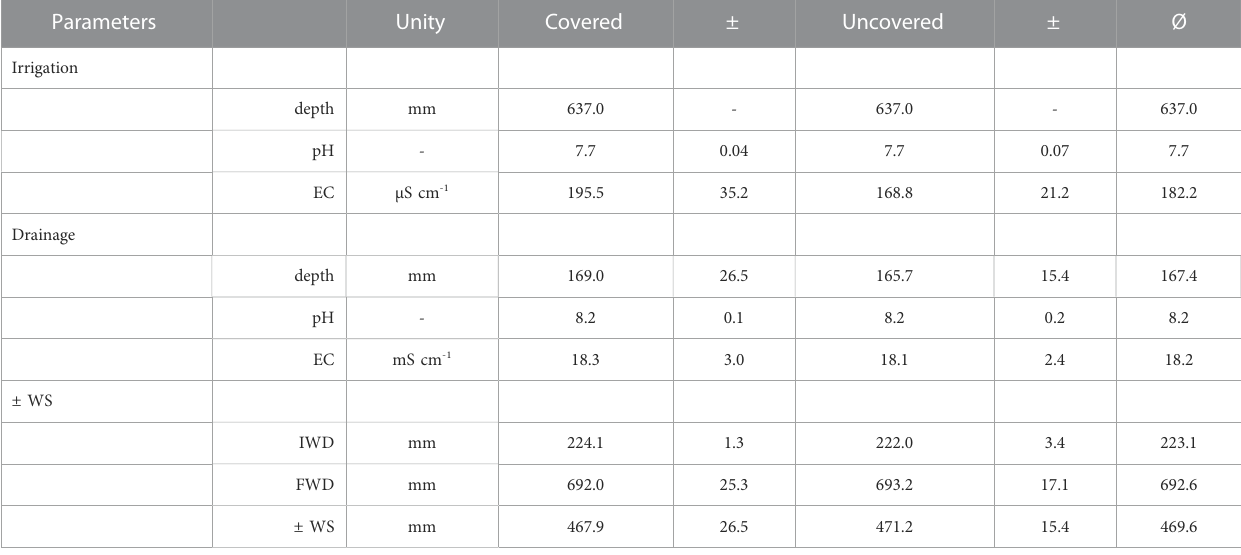
TABLE 4 Saturation of the covered and uncovered columns from 14.11.2015 to 14.01.2015. Values are presented as means ± standard deviation.